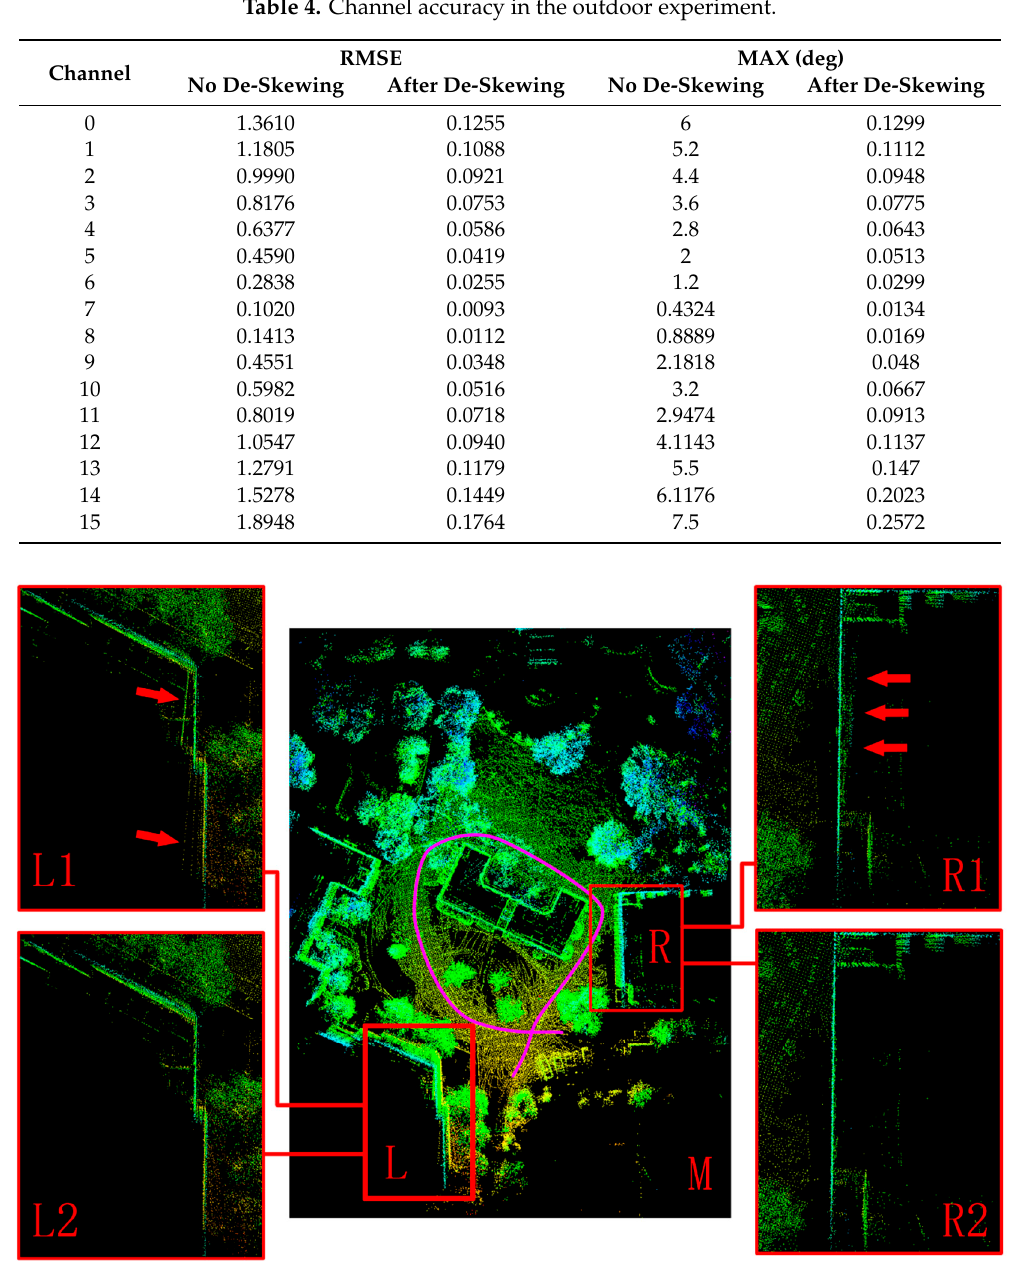
Figure 20. Outdoor experiment on a larger scale. The pink curve was the driving route. Different colors represent different reflection intensities of points. M: the scanned area, with two comparison areas L and R in red rectangles; L1: enlarged view of L without de-skewing; L2: enlarged view of L with de-skewing; R1: enlarged view of R without de-skewing; R2: enlarged view of R with de- skewing.